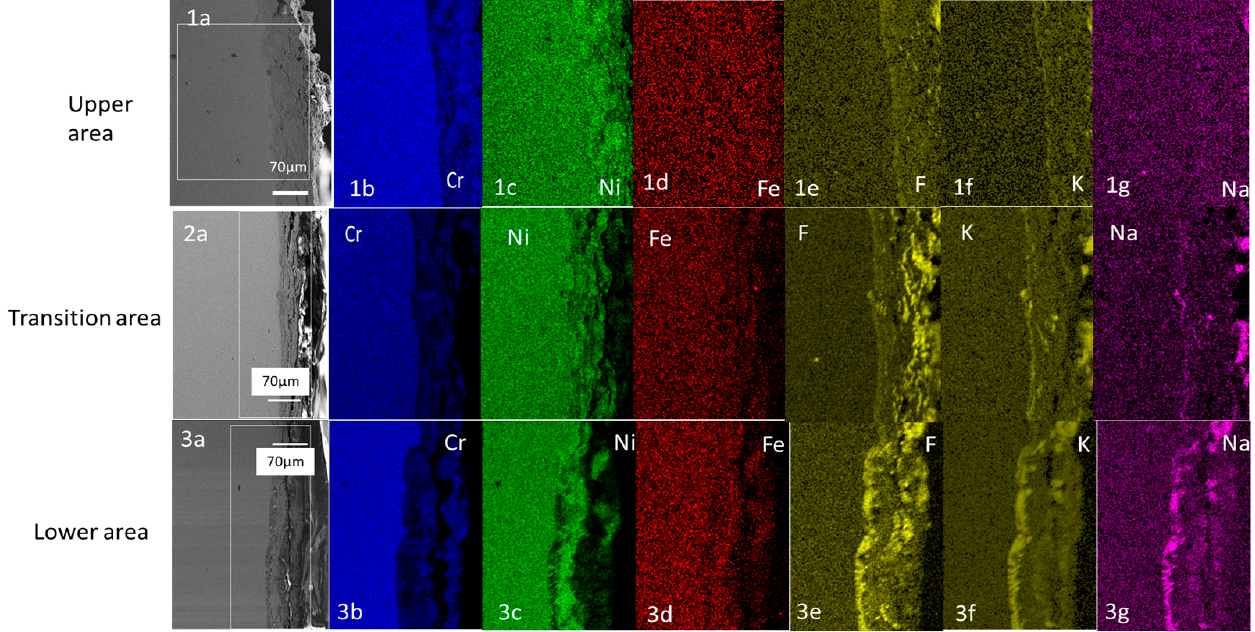
Figure 10. Cross-sectional elemental mapping of Hastelloy ® G35 ® is shows. Images ( 1a – 1g ) show the elemental distribution of the upper area. Images ( 2a ) show the and the consecutive images to its right show shows the elemental distribution of the transition area. Images ( 3a–3g) show the elemental distribution of the lower area.